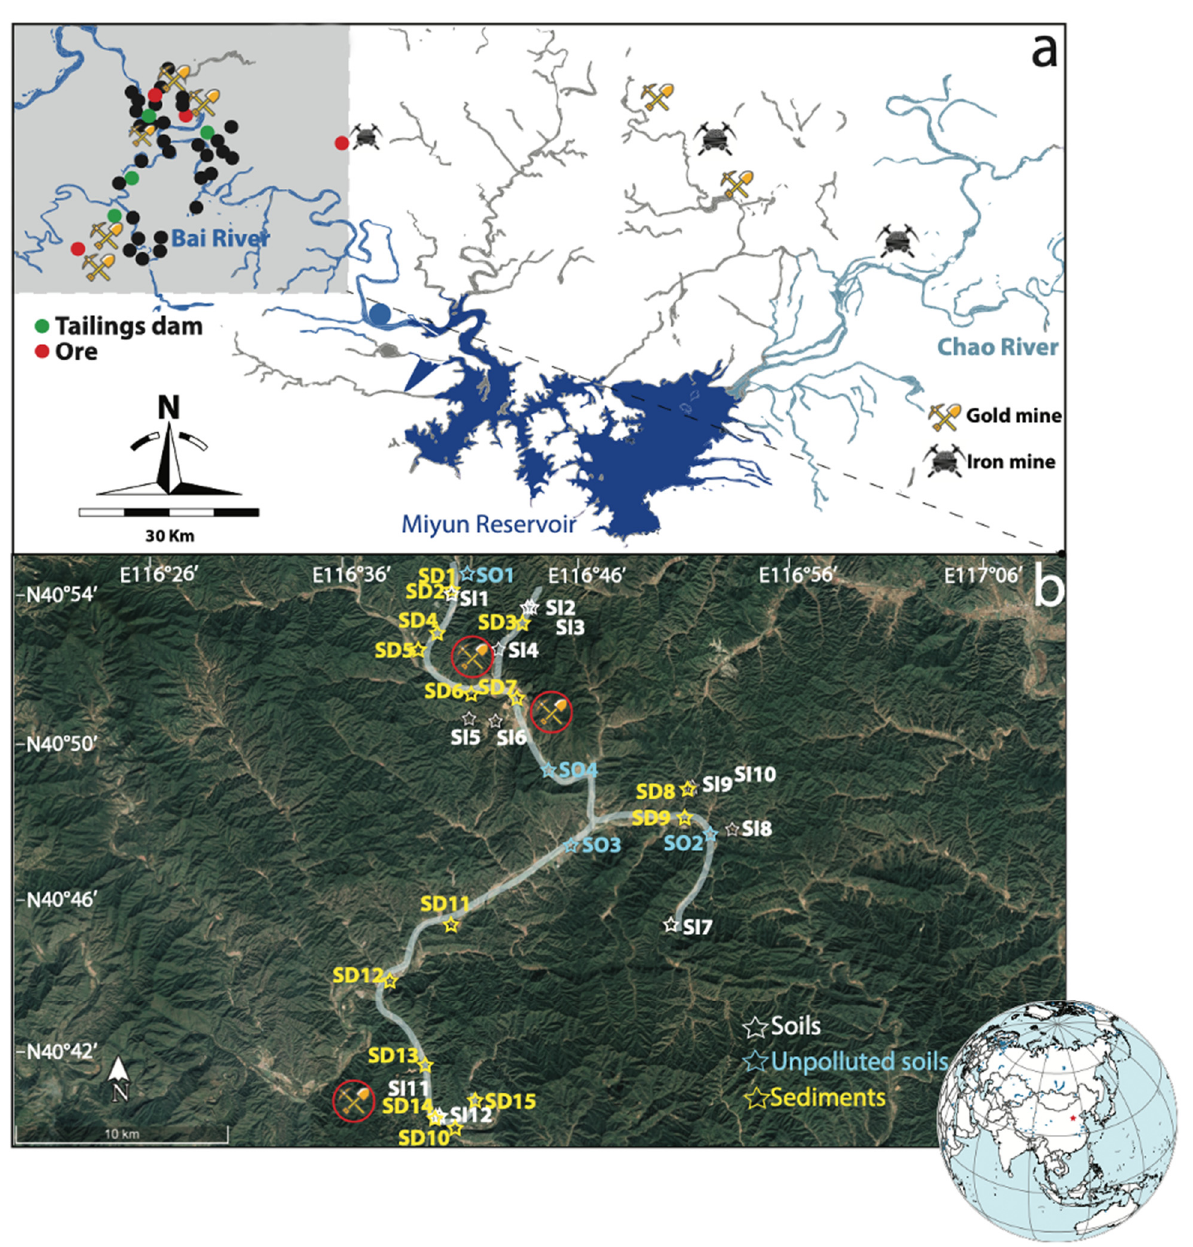
Figure 1. Map of the upstream of Miyun Reservoir ( a ); soils and sediments sampling sites ( b ).